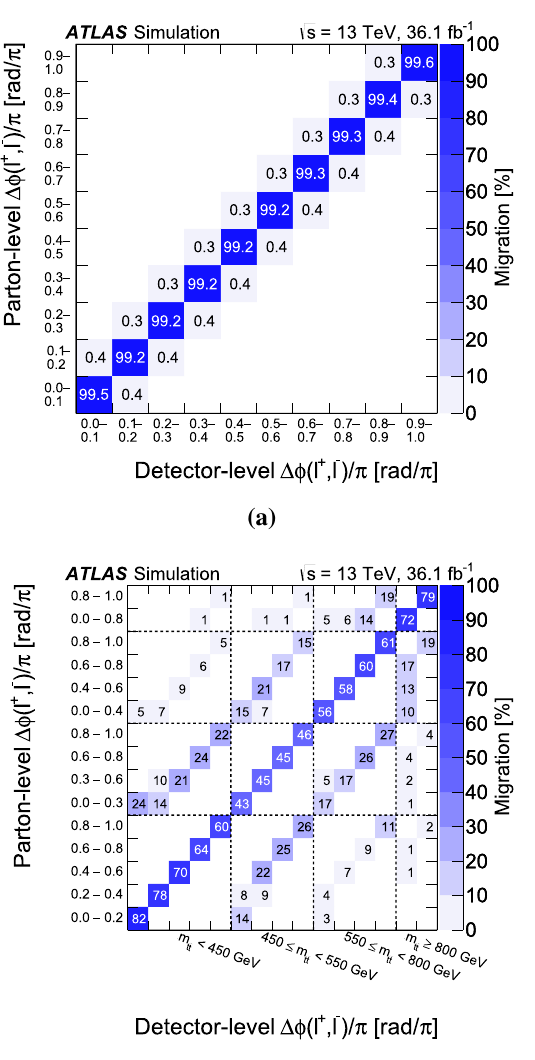
Fig. 5 Parton-level response matrices, normalised by row and shown as percentages, for: a (cid:3)φ , b (cid:3)η , and c (cid:3)φ as a function of m t ¯ t , after Neutrino Weighting. For ( c ), the binning on the horizontal and vertical